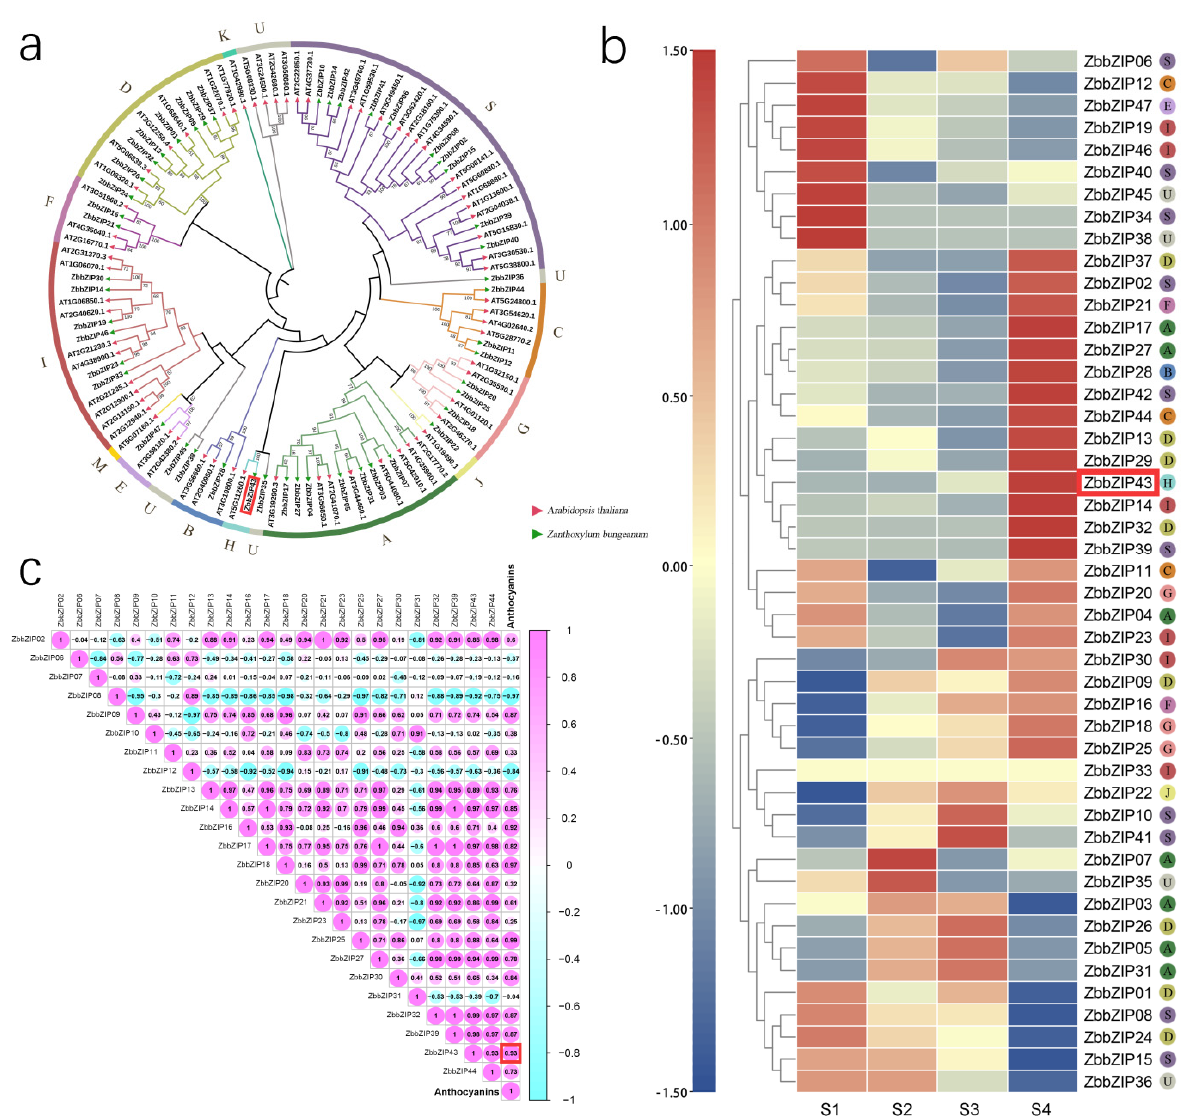
Figure 1. Phylogenetic tree and correlation analysis of HY5 and other bZIP family transcription factors in Z. bungeanum . ( a ) Phylogenetic tree of ZbbZIP transcription factor family. The phylogenetic tree was constructed using the neighbor joining (NJ) method. The ZbHY5 candidate, ZbbZIP43, is marked by the red box. ( b ) Heat map of bZIP transcription factor gene expression in Z. bungeanum fruits at different growth and development stages. ZbbZIP43 is marked by the red box. S1–S4 represent the four gradual ripening stages of Z. bungeanum fruit: S1 (green stage), S2 (light red stage), S3 (red stage), and S4 (deep red stage). ( c ) Heat map representing the correlation between bZIP transcription factor gene expression and the anthocyanin content in the different growth and development stages of Z. bungeanum fruit. The number in the box represents the correlation between the abscissa and the ordinate. The positive value represents a positive correlation, the negative value represents a negative correlation, and the larger the absolute value of the number is, the stronger the correlation is. The 0.93 marked by the red box shows that there was a positive correlation between the anthocyanin content and ZbbZIP43 expression, and the correlation coefficient was 0.93.